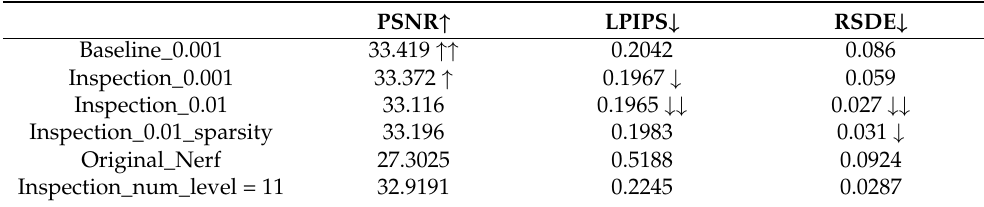
Table 1. Color and depth rendering metrics comparison of different models and loss settings. second best ↑ or ↓ best ↑↑ or ↓↓